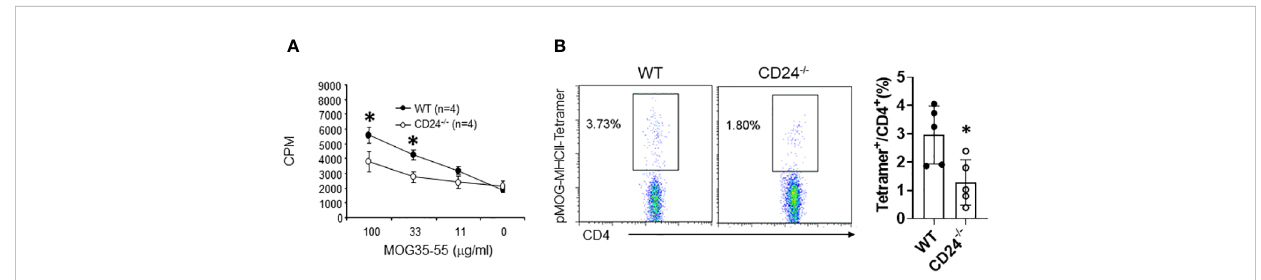
FIGURE 8 Reduced priming of MOG peptide-speci fi c T cells in lymph nodes from CD24 -/- mice. WT and CD24 -/- mice were immunization with MOG 35-55/ CFA. On day-10 after immunization, lymph node CD4 + T cells were assessed for proliferation (A) and pMOG-MHCII-tetramer staining (B) . Data shown represents two (A) and three (B) experiments with similar results. *P<0.05 by student ’ s t test.